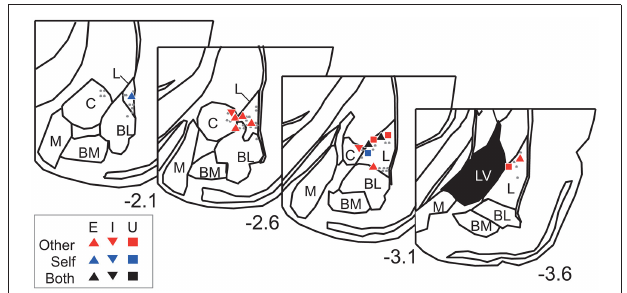
FIGURE 6 | Recording site histological analyses. Positions of Type-Other, Type-Self, and Type-Both neurons are represented by red, blue, and black symbols, respectively. The inset keys indicate response types. Gray dots represent positions of non-responsive neurons. The value below each section indicates distance (mm) from bregma. L, lateral amygdaloid nucleus; BL, basolateral amygdaloid nucleus; BM, basomedial amygdaloid nucleus; M, medial amygdaloid nucleus; C, central amygdaloid nucleus; LV, lateral ventricle. The atlas diagrams were adapted from Paxinos and Watson (2006) with